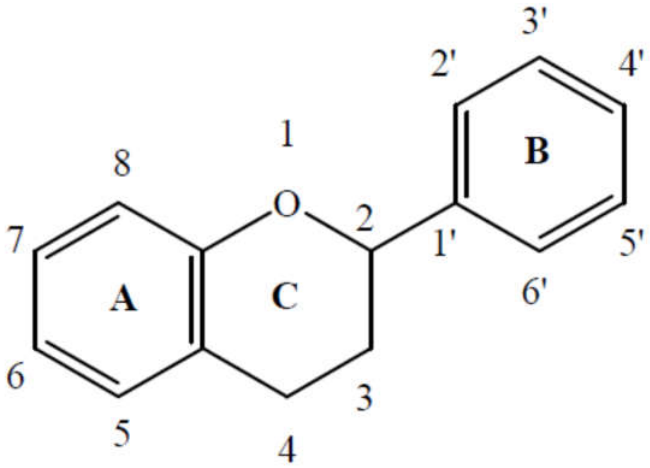
Figure 3. Flavonoids structure.